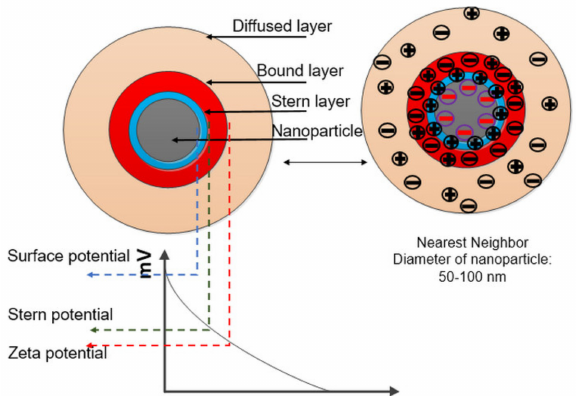
Figure 7. Study of zeta potential with the surface layer of the